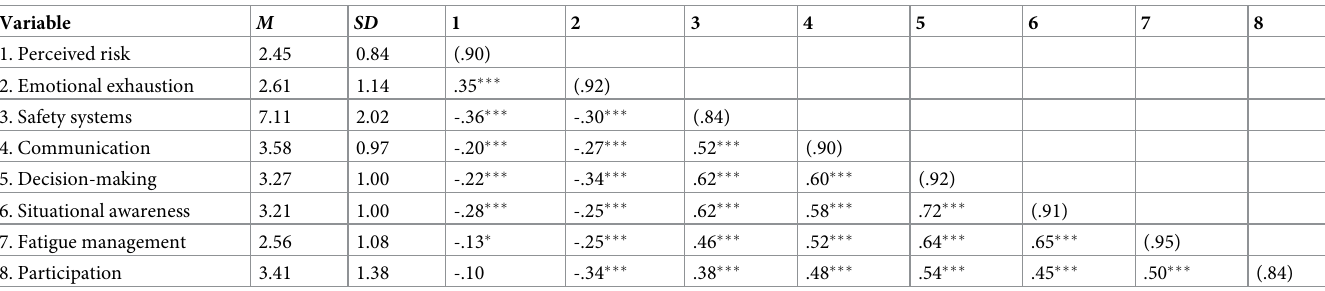
Table 1. Means, standard deviations, cronbach’s alphas, and correlations between study variables ( N = 358).